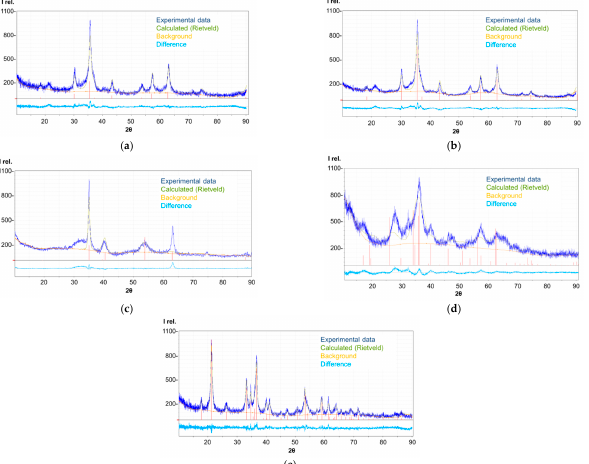
Figure 1. Experimental diffraction patterns of samples: ( a ) Fe 3 O 4 , ( b ) γ -Fe 2 O 3 , ( c ) δ -FeOOH, ( d ) 5Fe 2 O 3 ·9H 2 O, ( e ) α -FeOOH-Fe 2+ and the results of their refinement by the Rietveld method.